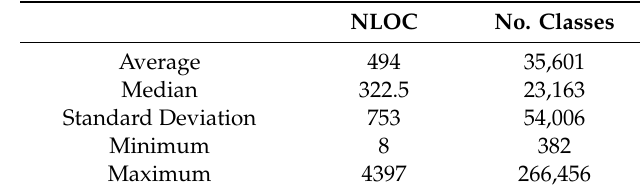
Table 3. Descriptive statistics about the size of analysed projects.